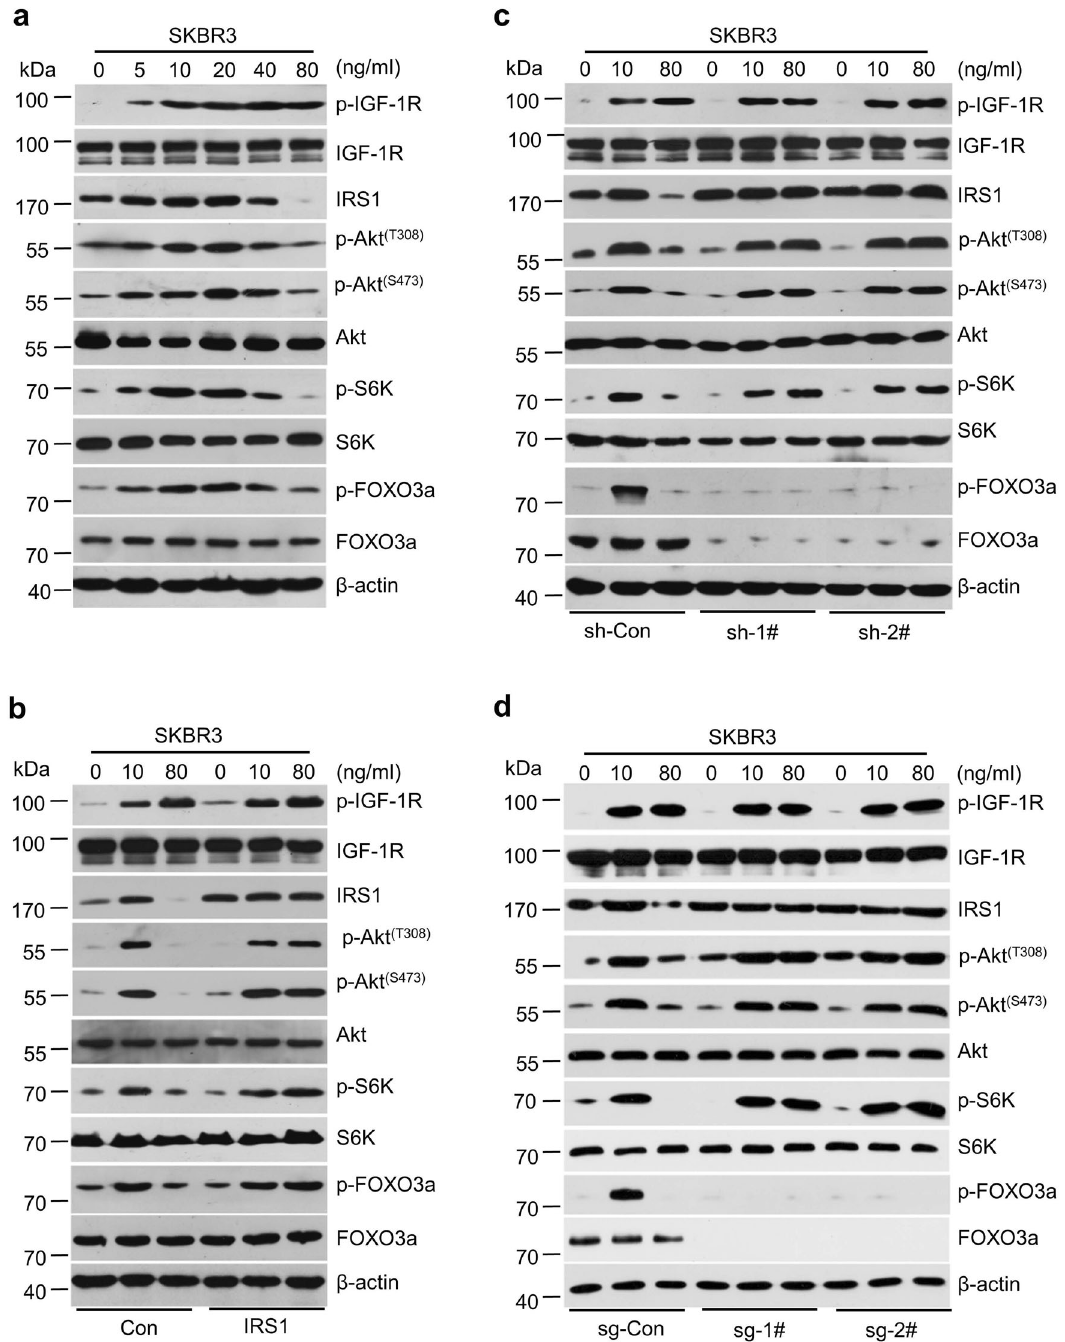
Fig. 2 FOXO3a and IRS1 regulated a negative feedback inhibition of IGF2-triggered IGF-1R/Akt/mTOR signaling in HER2-positive breast cancer cells. a SKBR3 cells were treated with rhIGF2 at indicated concentrations for 6 h. The expression of p-IGF-1R, IGF-IR, p-Akt (S473) , p-Akt (T308) , Akt, p-S6K, S6K, p-FOXO3a, FOXO3a, and β -actin was examined by western blot assays. b SKBR3 cells were transfected with a control empty vector (Con) or the same vector containing an IRS1 cDNA (IRS1), followed by rhIGF2 treatment for 6 h. The expression of indicated proteins was examined by western blot assays. c SKBR3 cells were transfected with control shRNA (sh-Con) or speci fi c FOXO3a shRNAs (sh-1# and sh-2#) followed by rhIGF2 treatment for 6 h. The expression of indicated proteins was examined by western blot assays. d SKBR3 cells with IRS1 gene deletion via CRISPR-Cas9 (sg-Con vs sg-1# and sg-2#) were treated by rhIGF2 treatment for 6 h. The expression of indicated proteins were examined by western blot assays. Data show a representative of three independent experiments ( a – d ). All data are provided in the Source Data fi